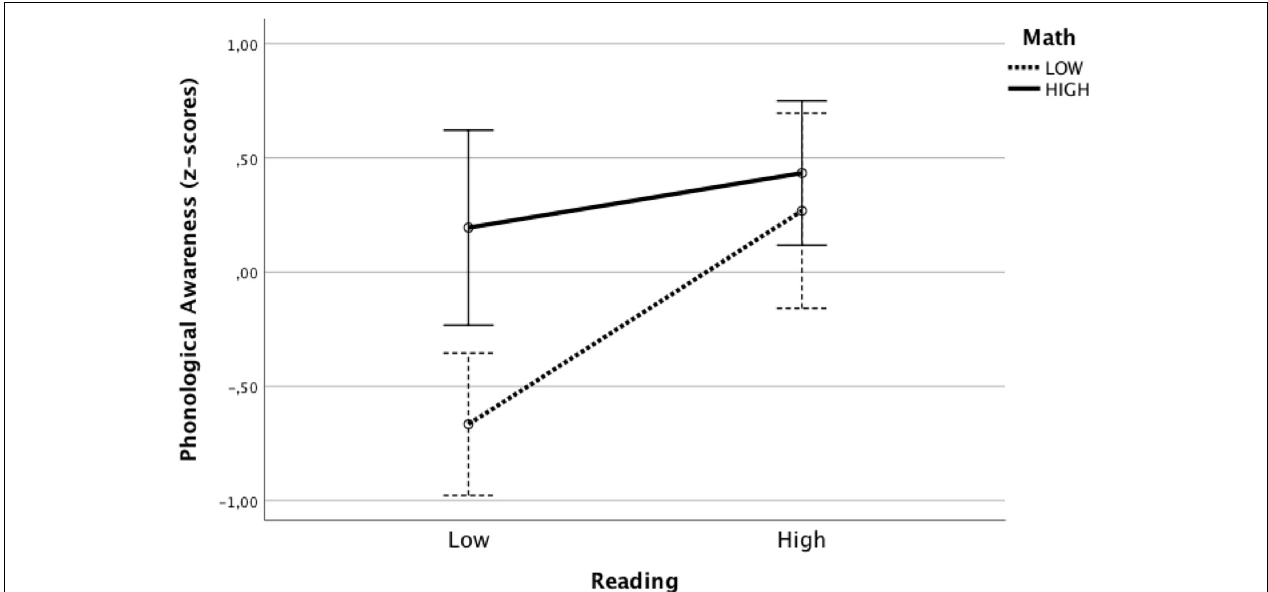
FIGURE 1 | Interaction of math and reading for groups of lower and higher scoring children. Error bars: 95% confidence interval